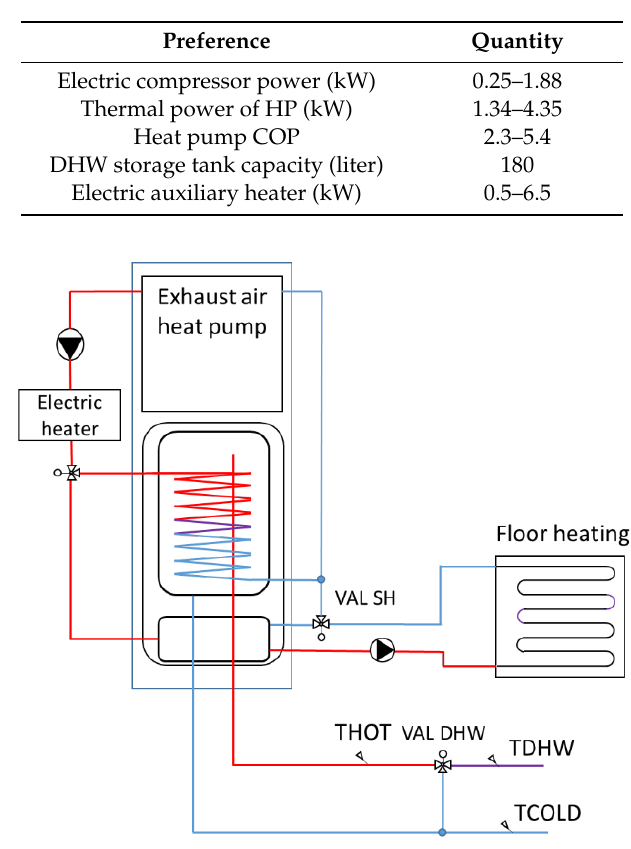
Figure 2. Layout of the exhaust air heat pump (HP) system and the hydronic system.